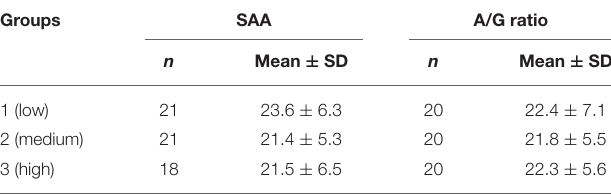
TABLE 5 | Interval level of SAA and A/G ratios in classified groups. Groups